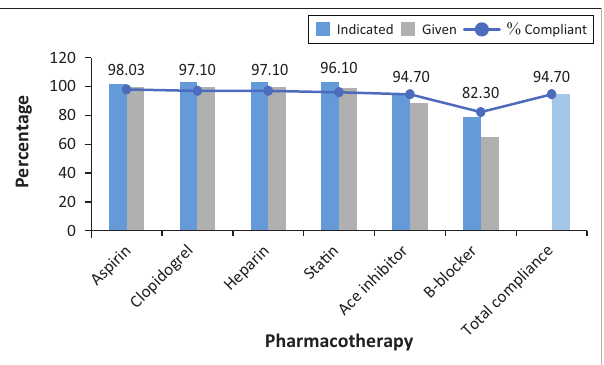
FIGURE 1: M edical management of acute myocardial